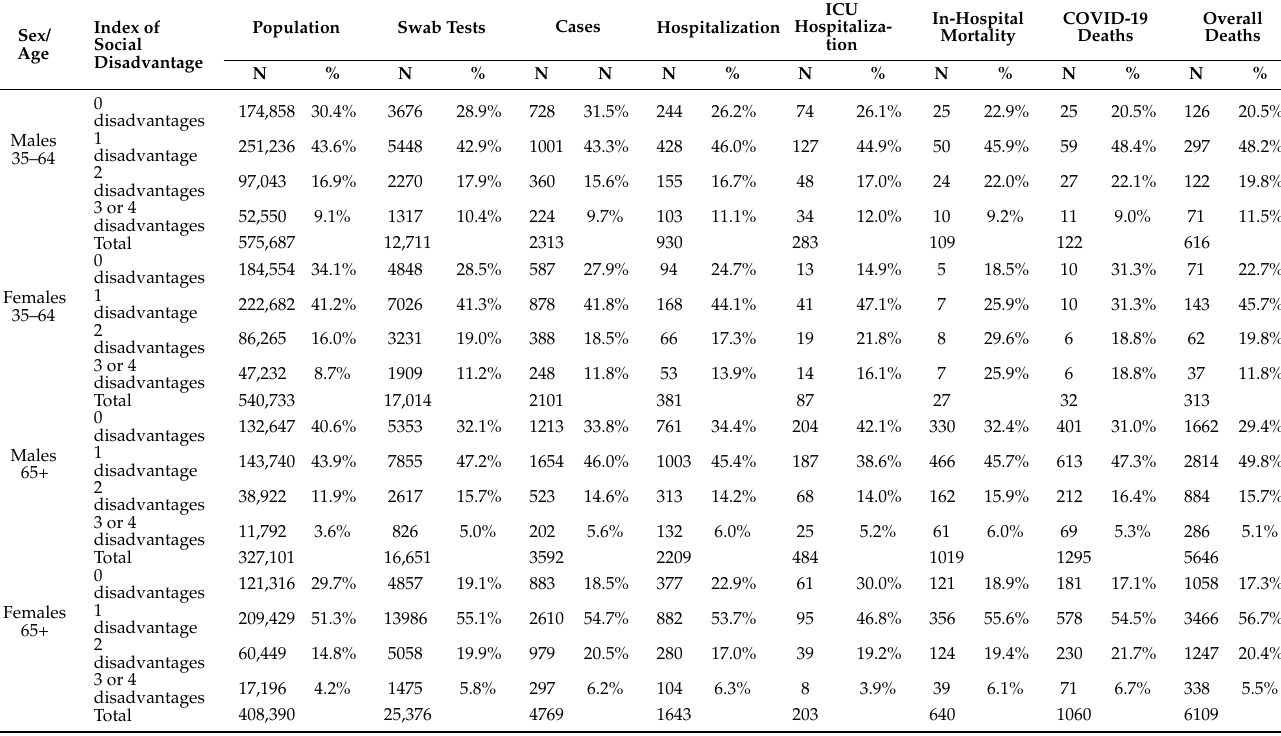
Table 1. Distribution of outcomes by individual Index of Socioeconomic Disadvantages (ISC) among men and women, aged 34–64 and over